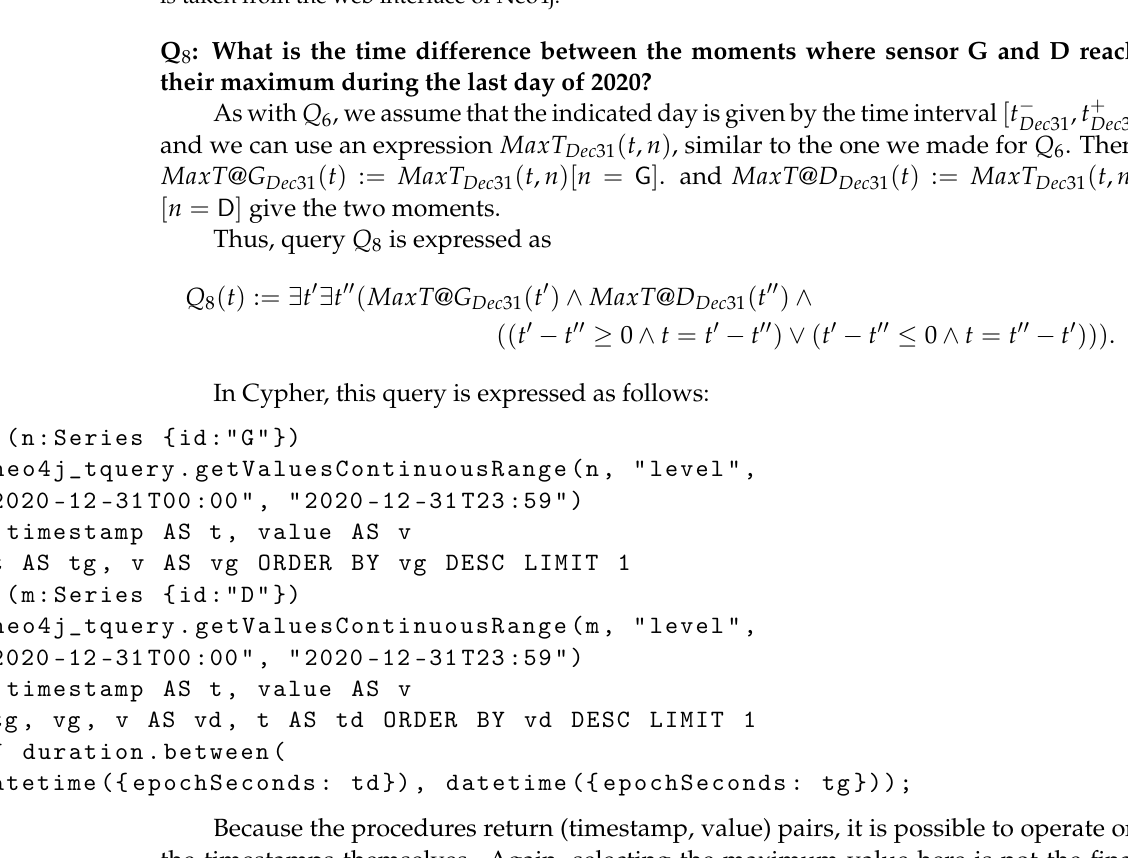
Figure 11. Visualization of the output of query Q 7 run on the sensor network of Figure 4. The result is taken from the web interface of Neo4j.